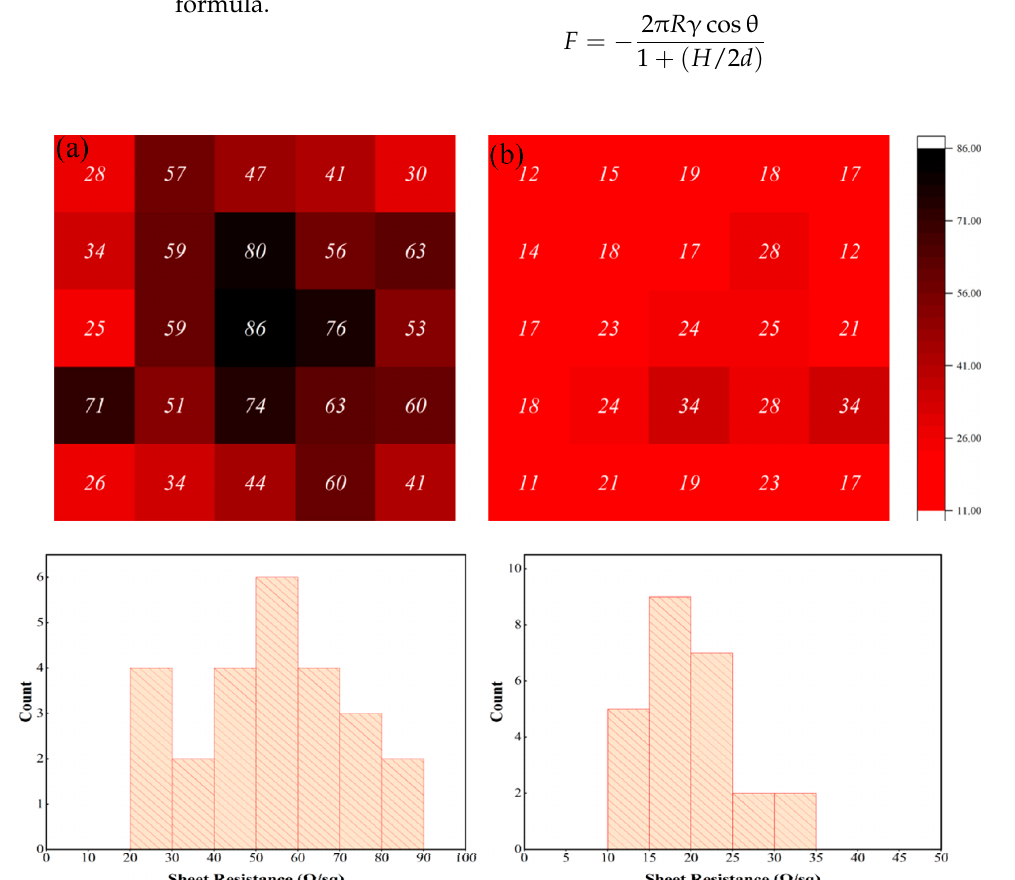
Coatings 2021 , 11 , x FOR PEER REVIEW 5 of 12